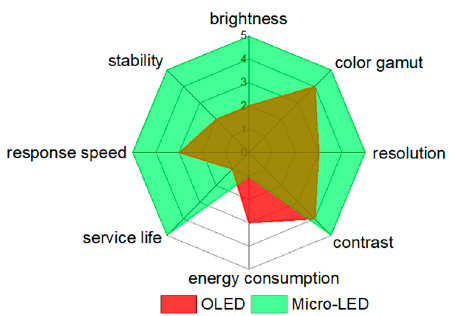
Figure 1. Radar chart of OLED vs. Micro-LED in several aspects.